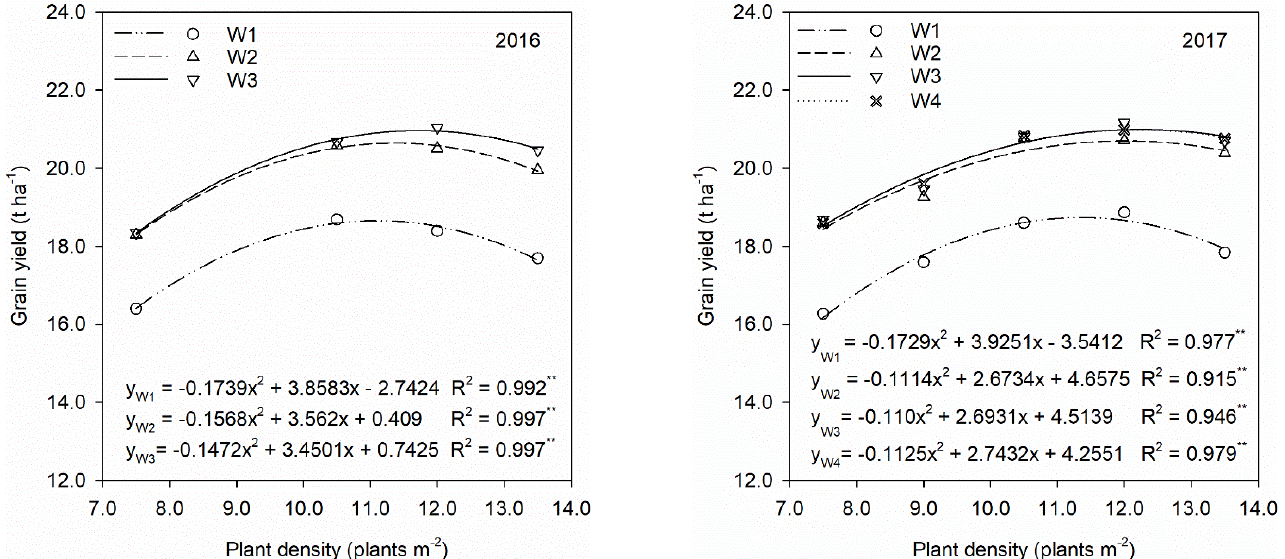
Figure 2. Relationships between grain yield and plant density under different irrigation levels in 2016 and 2017. ** denotes significance at the 0.01